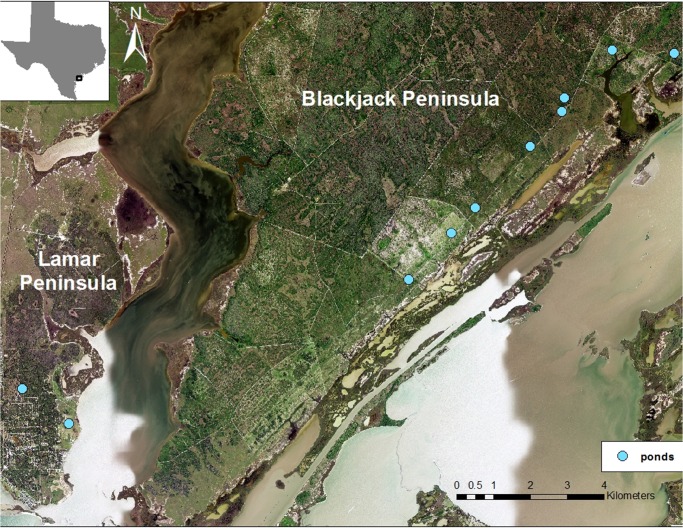
Pond Sites on the Blackjack and Lamar Peninsulas.The Aransas National Wildlife Refuge is located along the Texas Gulf Coast and encompasses the Blackjack Peninsula and Matagorda Island. Eight pond sites in this study were located on the Blackjack Peninsula. The two pond sites on the Lamar Peninsula were included during 2012–2013. The map image was created by the USDA National Agriculture Imagery Program (NAIP) and downloaded as a GIS file, and the figure was produced using ArcMAP 10 (Esri, Redlands, CA).